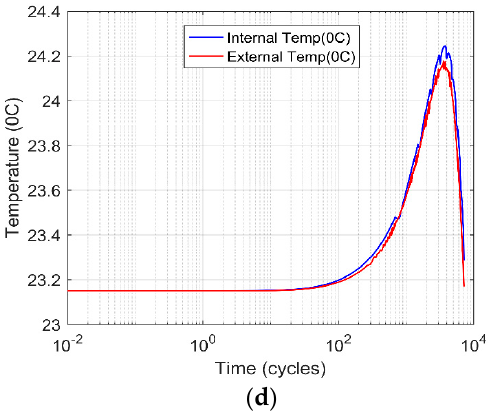
Figure 15. Simulation results of battery pack: ( a ) state-of-charge, ( b ) state-of-health, ( c ) internal temperature curve, ( d ) internal and external temperature variations